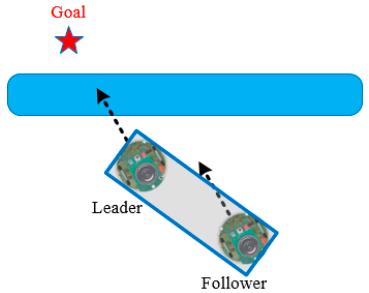
Figure 25. Leader robot encounters an obstacle.